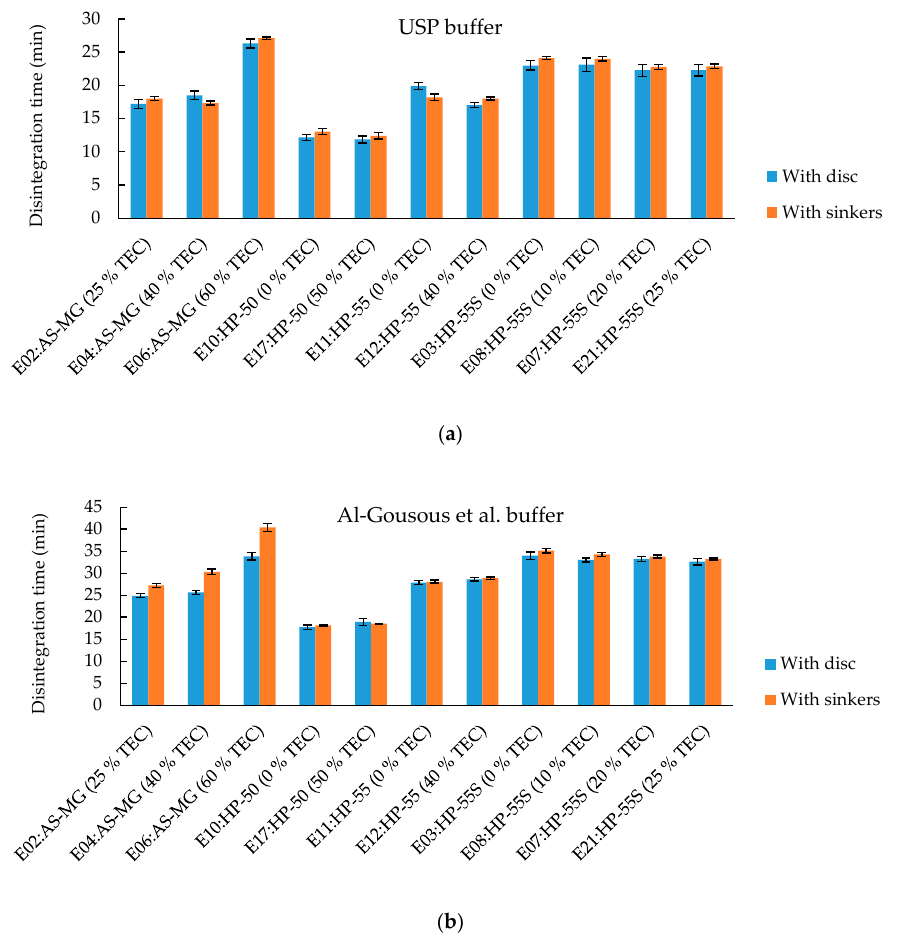
Figure 10. Comparison of disintegration test with disc vs. without disc but with sinker. Given are average disintegration times ± SD; n = 6. TEC content is based on dry polymer weight. ( a ) Shows the disintegration times in the USP disintegration media ( b ) Shows the disintegration times in the more biopredictive Al-Gousous et al. bu ff